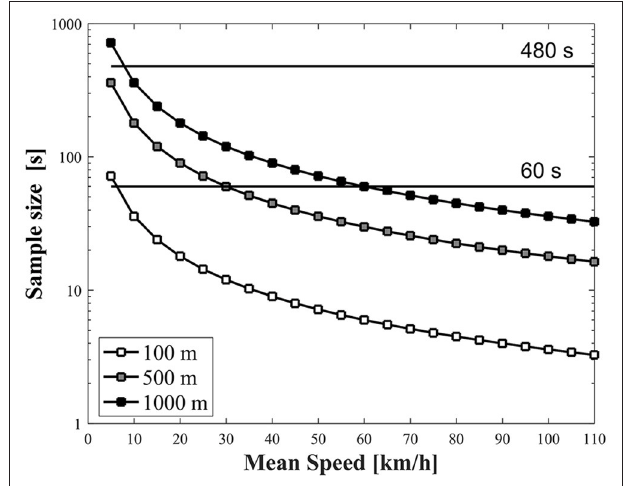
FIGURE 6 | Sample size for different integration methods as a function of mean traveling speed within each sample.